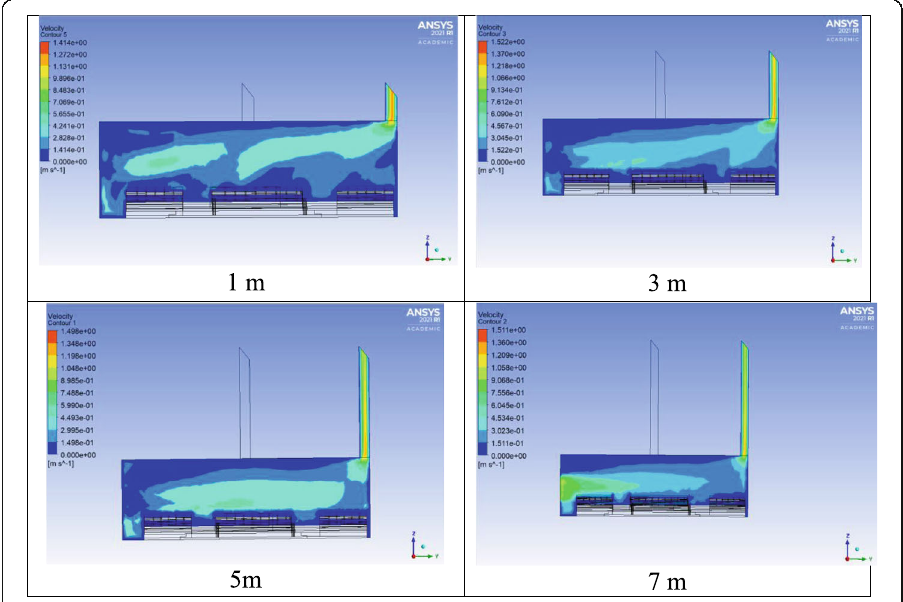
Fig. 22 Contours of air velocity at different heights of the chimney at the breathing level of students 1.20 m, output from the ANSYS CFD model